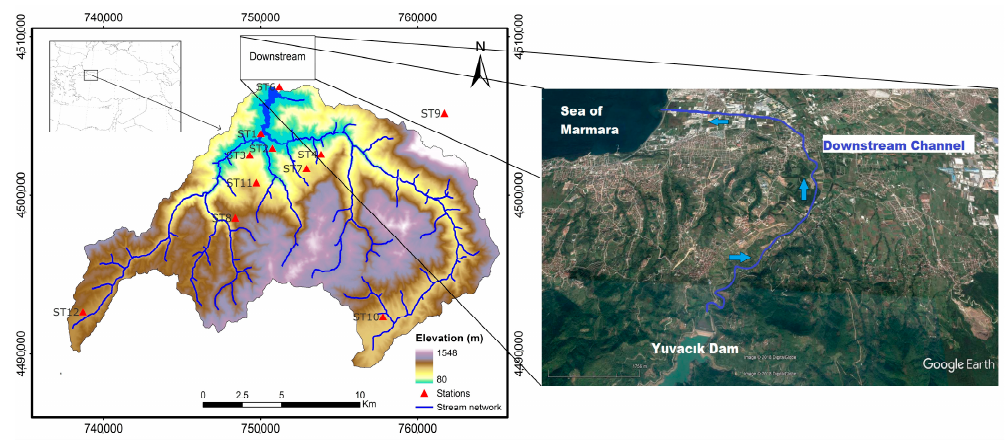
Figure 3. Yuvac ı k Basin DEM, station network and downstream region. Figure 3. Yuvacık Basin DEM, station network and downstream region.